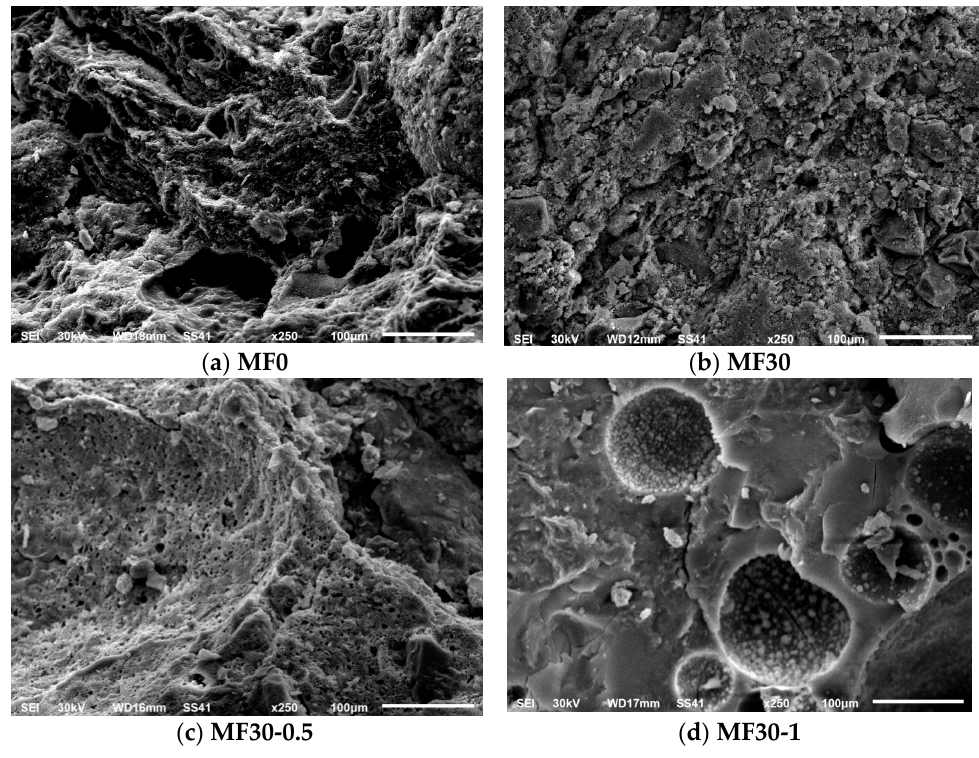
Figure 10. SEM images of concrete. ( a ) MF0, ( b ) MF30, ( c ) MF30-0.5, ( d ) MF30-1. Table 4. XRD diffraction